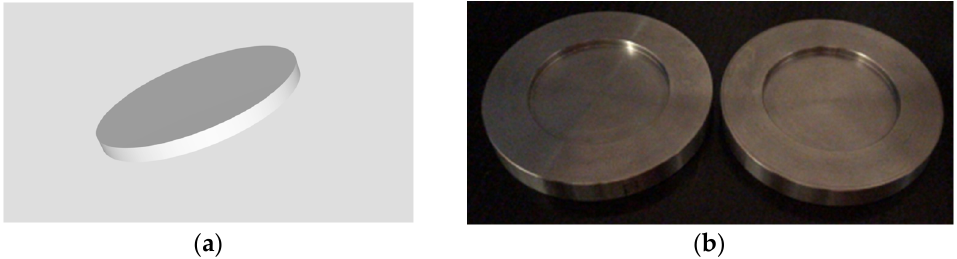
Figure 1. ( a ) A 2D frame corresponding to the digital design of the milled PMMA and 3D printed specimens; ( b ) conformers used in the manufacturing of the indirect composite resin and pres- sure/heat-cured acrylic resin